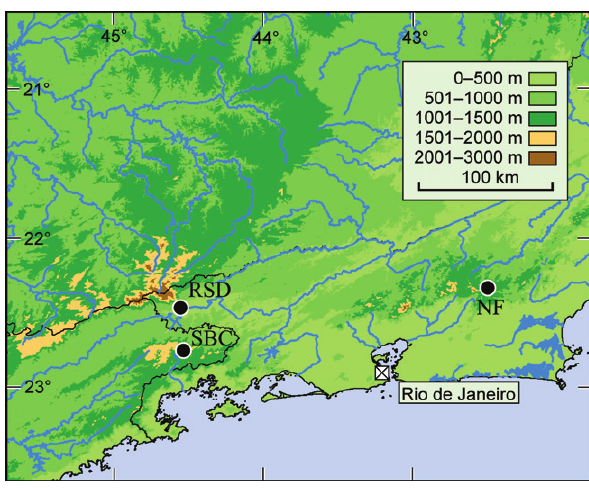
Figure 16. Geographic distribution of Fritziana ulei . Acronyms: (SBC) Parque Nacional da Serra da Bocaina, (RSD) Resende, (NF) Nova Friburgo,